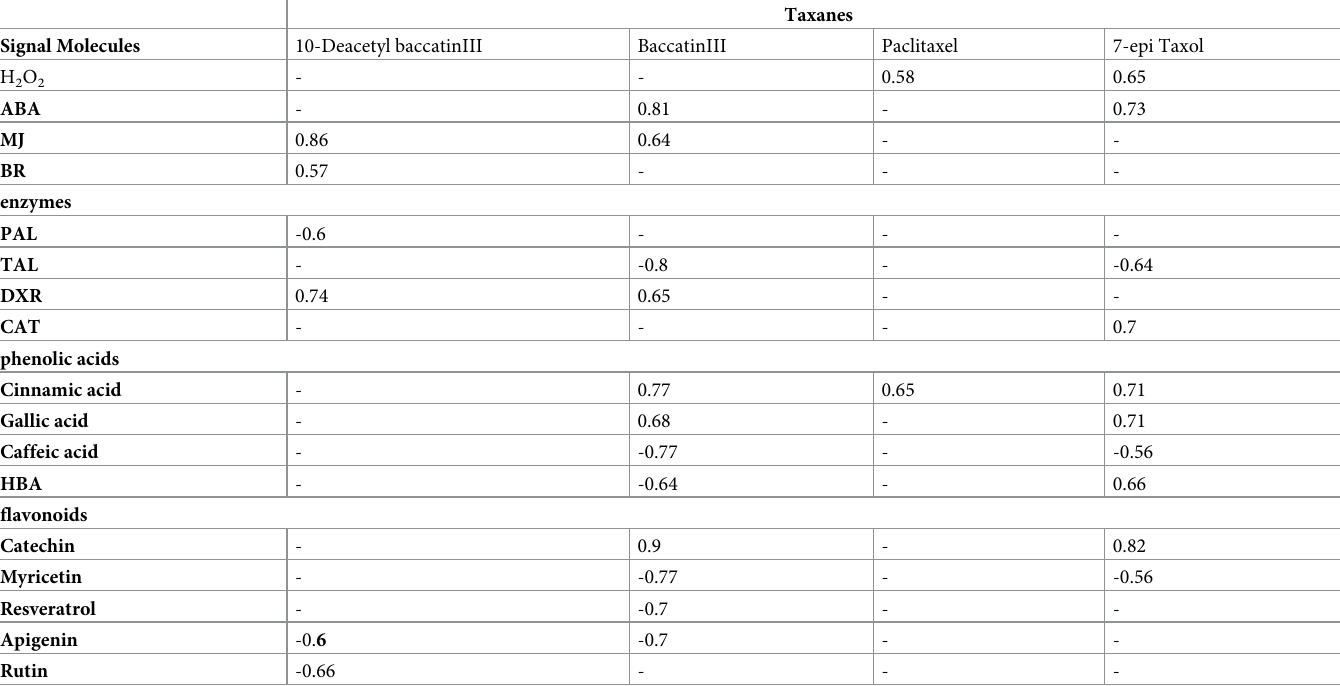
Table 2. The correlations between taxanes and signal molecules, enzymes, phenolic acids and flavonoids in C . tarraconensis . Signal